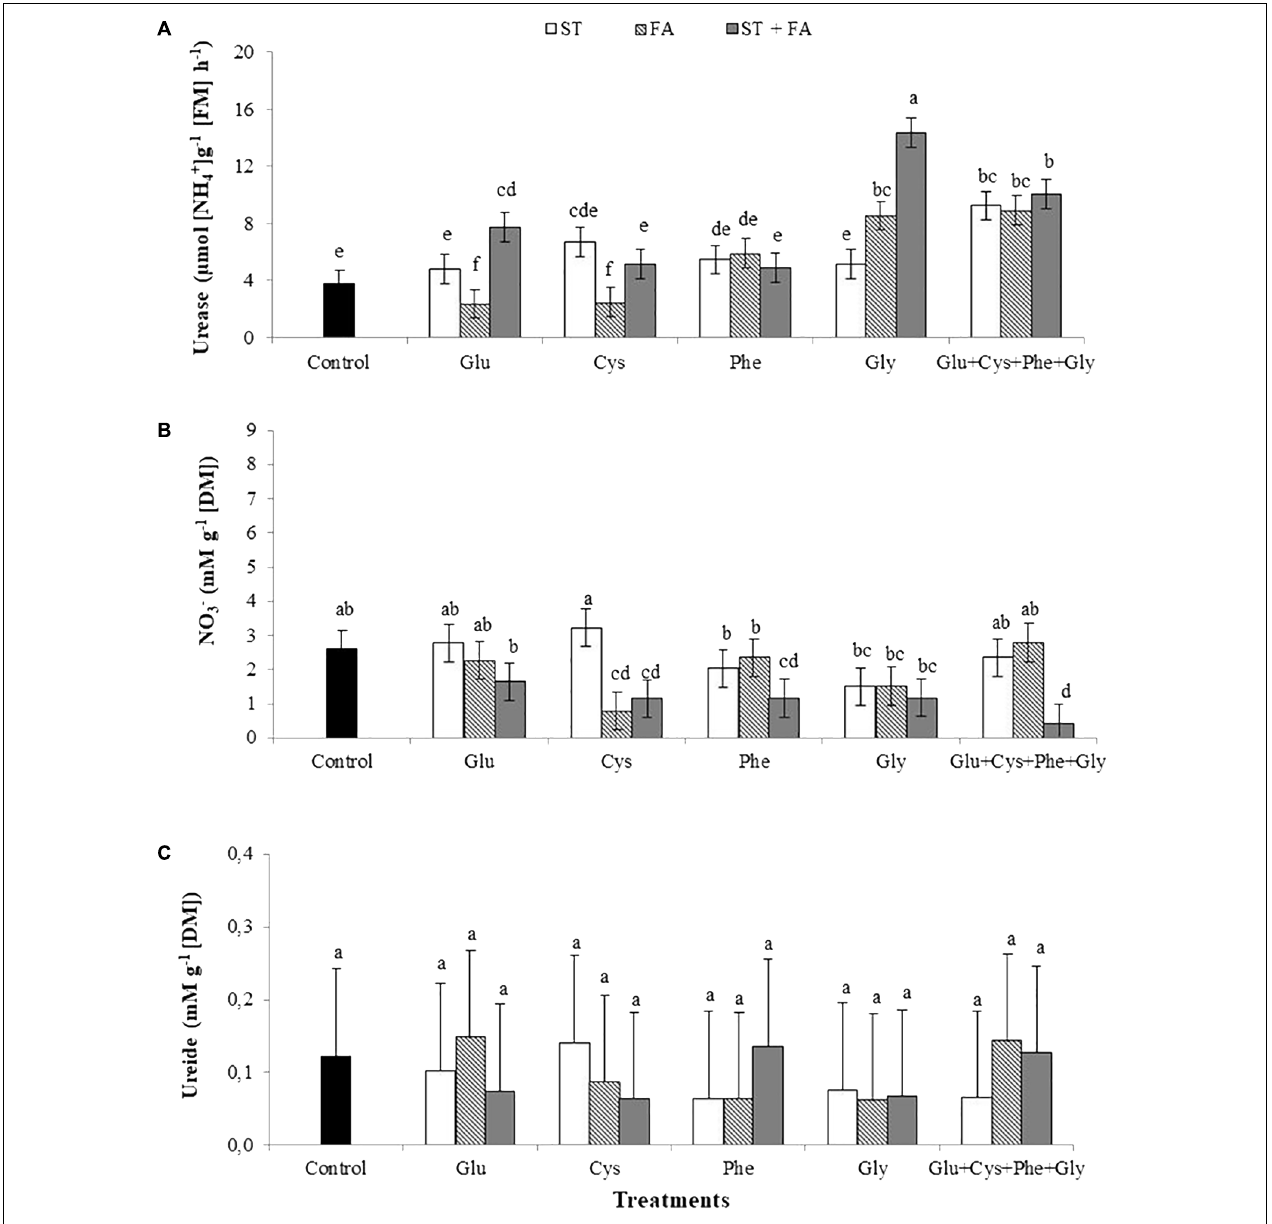
FIGURE 1 | Effects of use of glutamate (Glu), cysteine (Cys), phenylalanine (Phe), glycine (Gly) and all these amino acids in association (Glu+Cys+Phe+Gly), as a function of seed treatment (ST) and/or foliar application (FA), on the soybean leaf urease activity (A) , nitrate (NO 3 − , B ) and ureide (C) at V 6 stage. Greenhouse experiment. Season 2015/2016. Means followed by the same letters do not differ significantly from each other, using the Duncan test at 5%